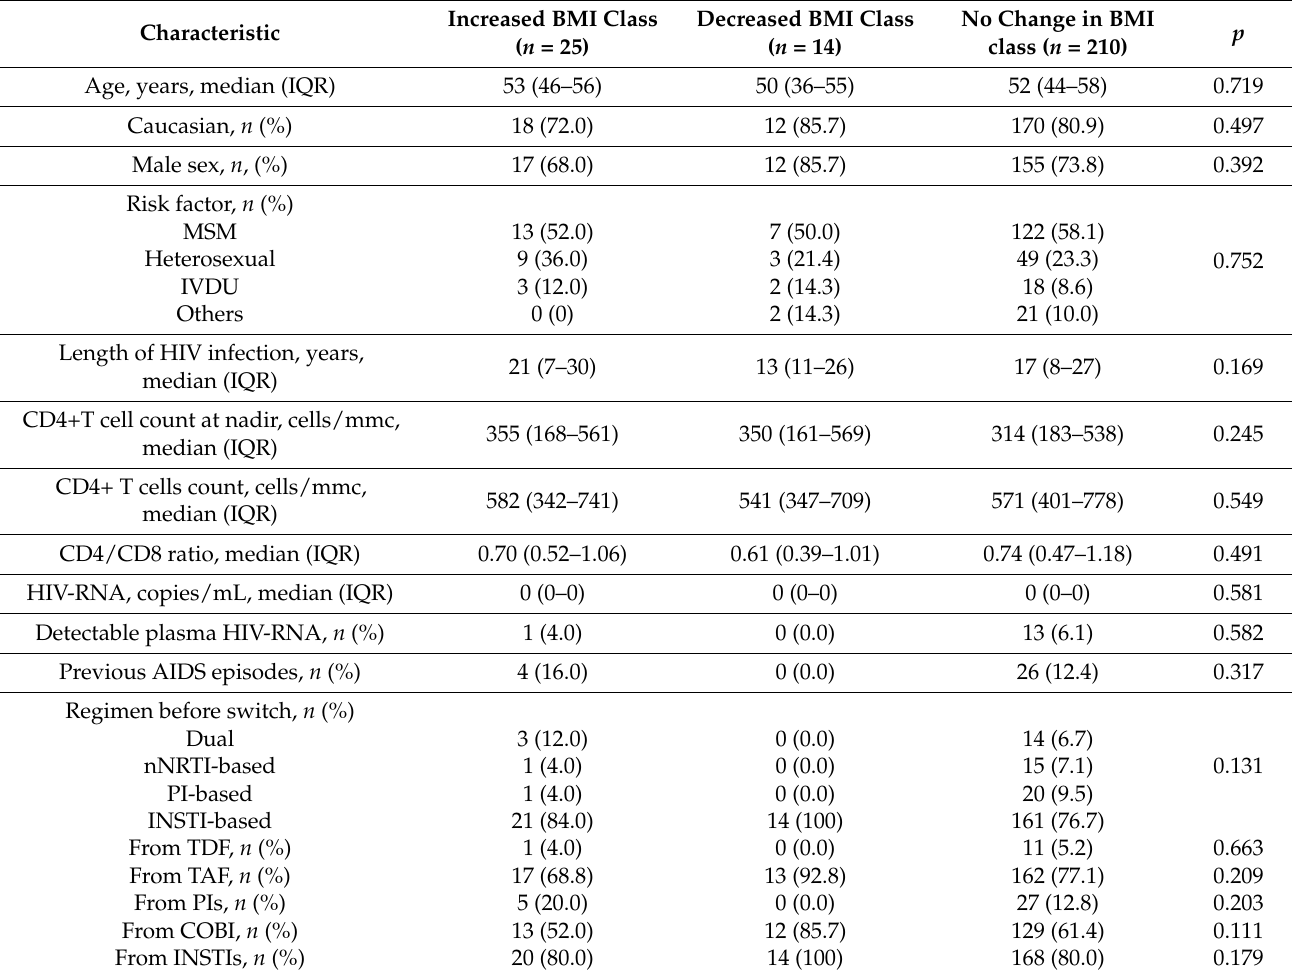
Figure 1. Proportion of individuals according to BMI categories before and after switching to BIC/FTC/TAF. No statistically significant differences were detected among BMI categories. Table 4. Comparison among the three individual categories identified based on the change in BMI class from baseline to W48.